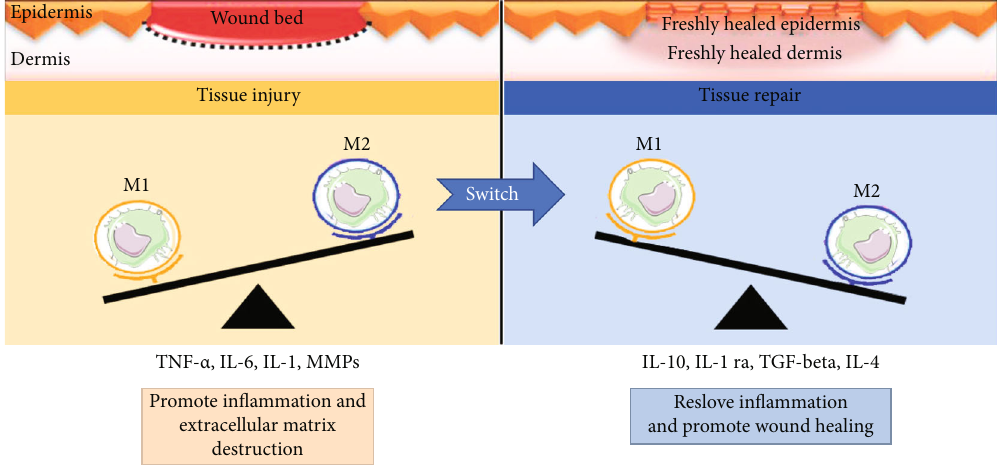
Figure 4: Macrophage polarization (switch M1/M2) during wound